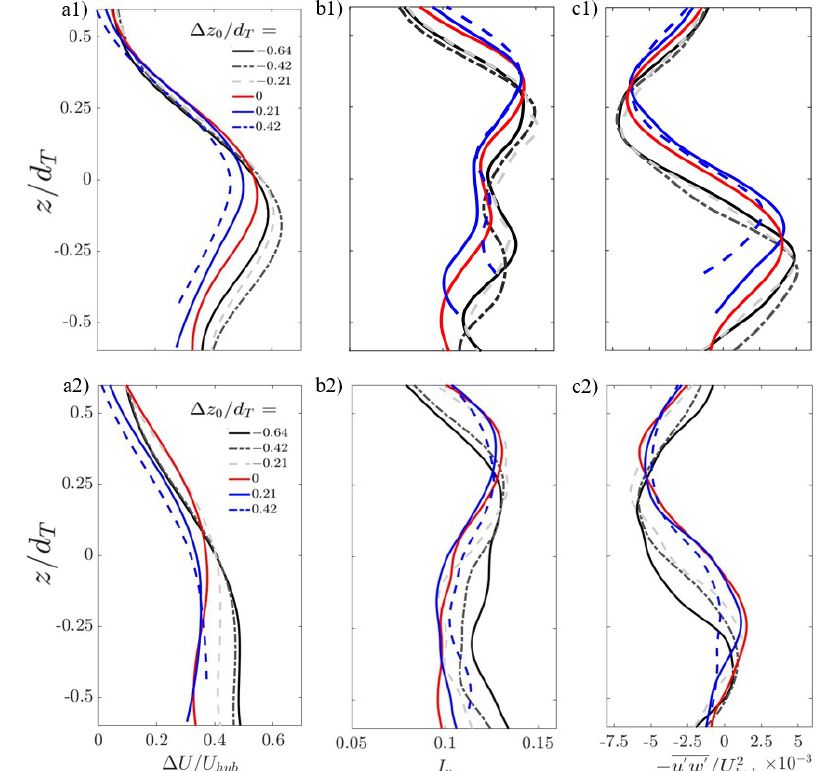
Figure 7. Vertical profiles of: ( a1 , a2 ) the velocity deficit ∆ U / U hub ; ( b1 , b2 ) turbulence intensity I u ; and ( c1 , c2 ) kinematic shear stress − u (cid:48) w (cid:48) / U 2 for the backward- and forward-facing step cases and hub flat terrain. Profiles were obtained at: ( a1 , b1 , c1 ) x / d T = 2.5; and ( a2 , b2 , c2 ) x / d T =